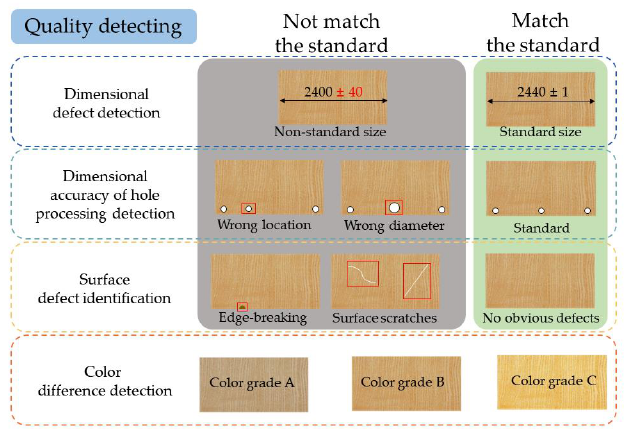
Figure 4. Application of quality detecting.